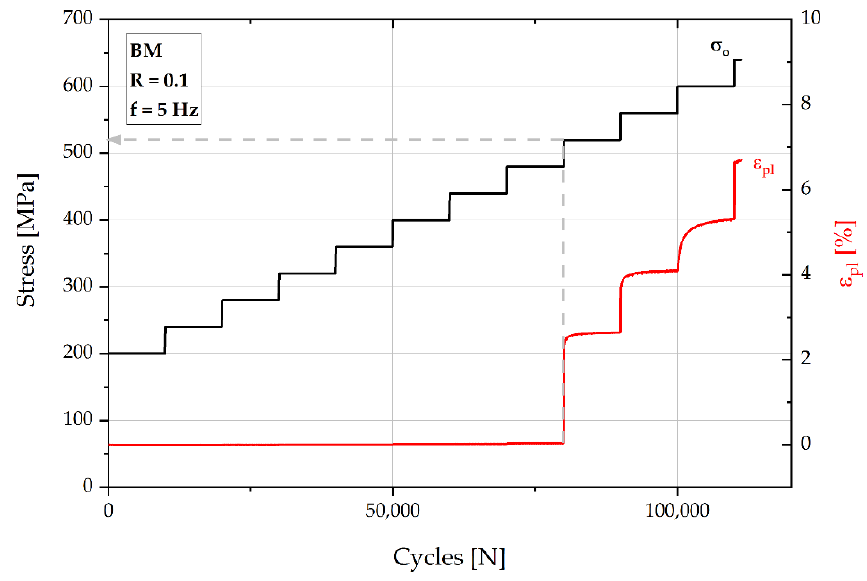
Figure 7. Load Increase Test for the cold-rolled base material. The cold-rolled condition failed at a maximum stress of about 680 MPa after about 110,000 cycles.